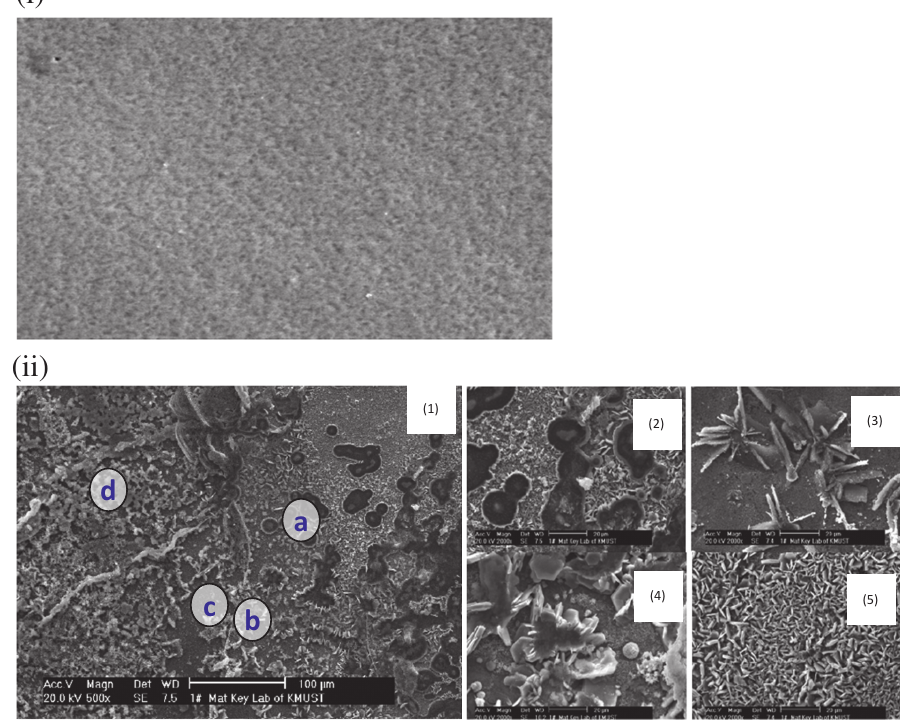
Figure 3: (i) The SEM of the cerium conversion coating of the zinc coating, and (ii) The SEM of the corrosion products of cerium conversion coating of zinc coating in a 5% NaCl solution (1) The regional corrosion; (2) The part a of the corrosion region; (3) The part b of the corrosion region; (4) The part c of the corrosion region; (5) The part d of the corrosion